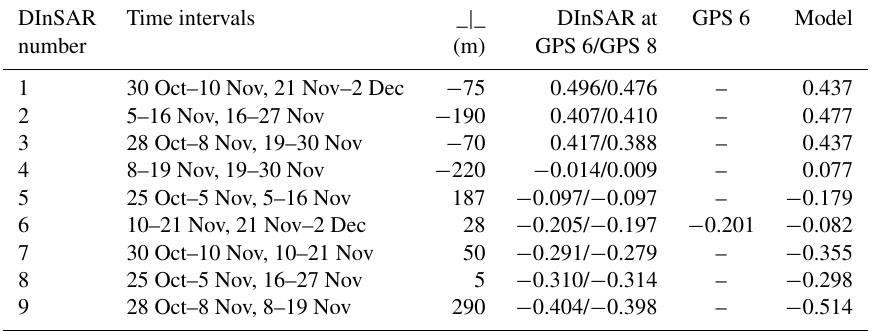
Table 3. Acquisition dates and spatial perpendicular baselines (_ | _) of differential interferograms listed with displacements (in m) at the freely floating ice shelf (position GPS 6 and 7) compared to the adjusted CATS tide model. For DInSAR combination 6 the corresponding value measured by GPS 6 is also shown.